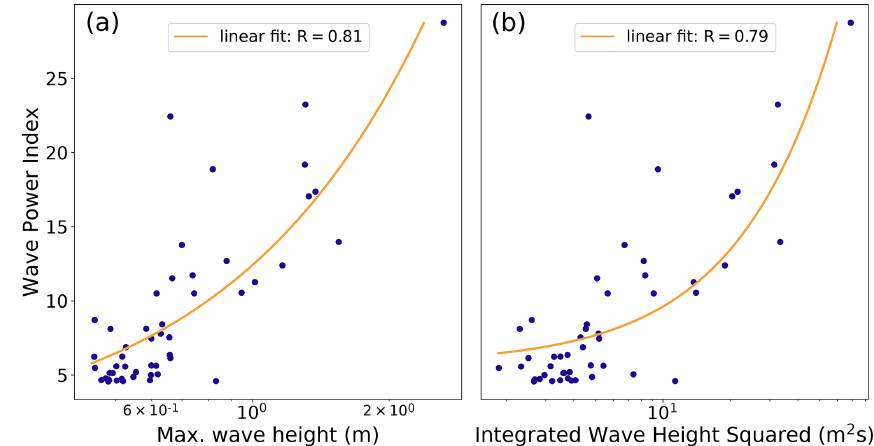
Figure 8. (a) Relation between wave power index (WPI) and maximum wave height and (b) integrated wave height squared (IWHS) for the 50 biggest waves recorded by the pressure sensor, on linear-log scales. The IWHS (measure of wave energy) is computed within a ± 3min interval around the maximum wave height. The orange lines correspond to linear fits using linear least squares applied to each data set and are associated with their respective R correlation coefficients.